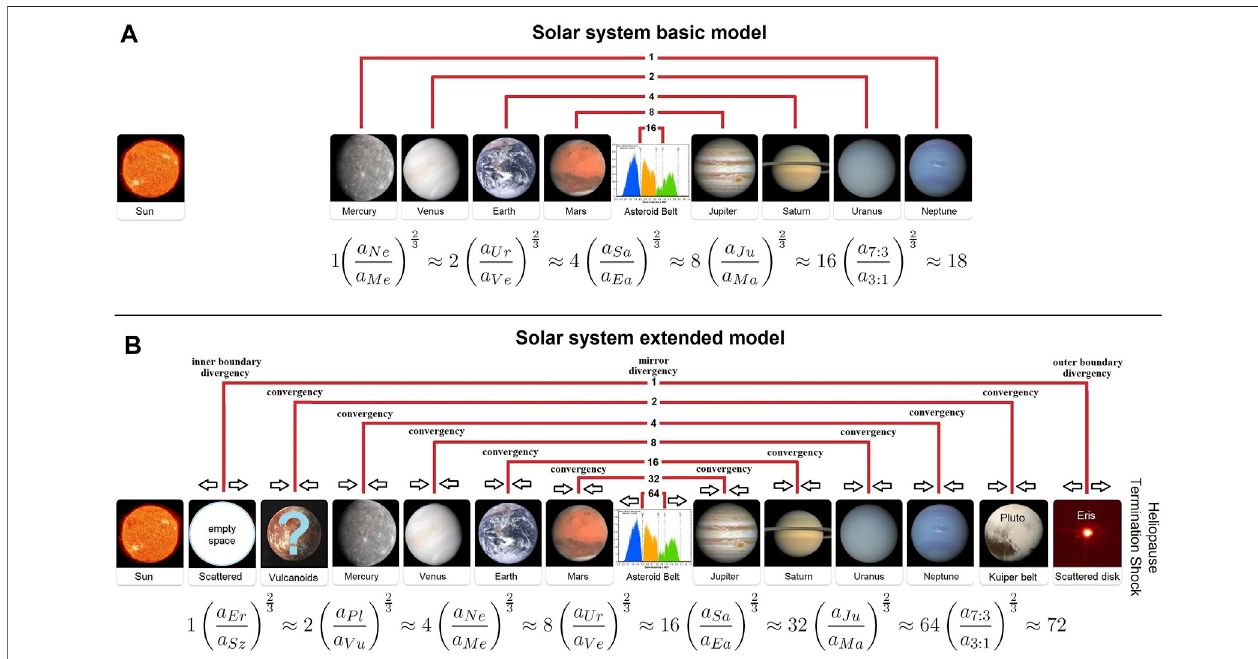
FIGURE 7 | (A) Graphical representation of Eq. 25 expressing the scaling and the mirror symmetries among the semi-major axis lengths of the eight planets of the solar system, including the central region of the asteroid belt, according to the 12-TET model of the Geddes – King-Hele equations (99% accuracy). (B) Graphical representation of the hypothesized scaling and mirror-symmetric planetary organization of the solar system according to the extended model ( Eq. 26 ). The ratio sequences are based on the Pythagorean epogdoon (the interval ratio 9/8 (cid:1) 18/16 (cid:1) 72/64) and its addition with up to six octaves.